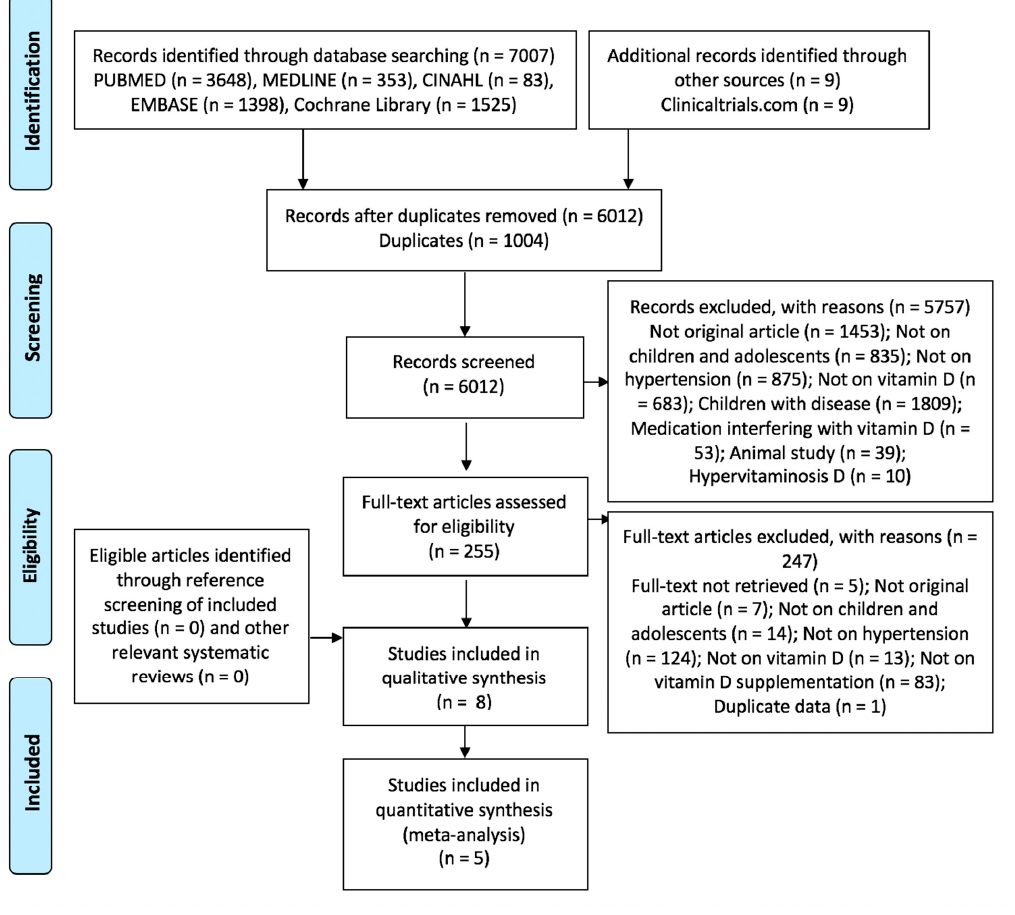
Figure 1. Preferred Reporting Items for Systematic Reviews and Meta-Analyses (PRISMA) diagram of study selection.